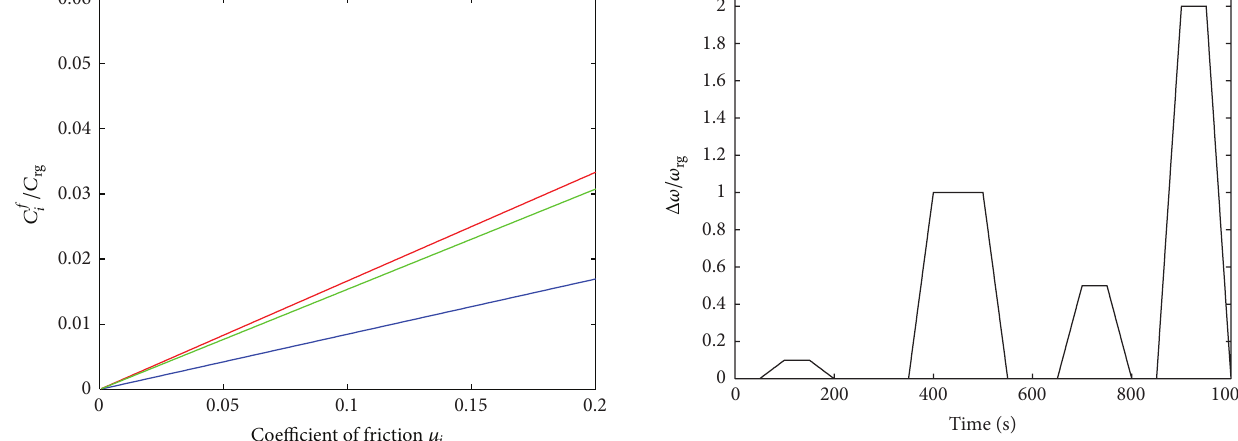
Figure 12: Example of a load parameter Δ𝜔/𝜔 with a complex path rg as a function of coefficient of = 0 (in the case rg depending on time 𝑡 ∈ [0,1000 s ] : when Δ𝜔/𝜔 rg ̸=0 and 𝜔 ̸= 0 ) then 𝜂 = 1 and 𝑙 = 𝑃 /𝑃 = 0 , ∀𝑖 (when where 𝜔 /𝐶 𝑖 𝑖 lw rw di rg increased linearly with 𝜇 < 2 ax / sa rg ax / sa thevehiclewastravellingalongastraightline),when 0 < Δ𝜔/𝜔 /𝐶 = 𝜇 rg increased linearly with 𝜇 (blue < 1 and 𝑙 = 𝑃 /𝑃 > 0 , ∀𝑖 (when the vehicle was taking a sa / sh rg sa / sh sh then 𝜂 /𝐶 = 𝜇 𝑖 𝑖 di rg increased linearly with 𝜇 (green solid = 2 then 𝜂 < 1 and 𝑙 = 𝑃 /𝑃 > pl / sh rg pl / sh sh curvilinear course), when Δ𝜔/𝜔 𝑖 𝑖 rg di rg 0 , ∀𝑖 (when one of the driven wheels underwent slipping, the vehicle = constant and |𝜔 −𝜔 | = was stationary); on the plateau, Δ𝜔/𝜔 rg lw rw constant (the vehicle was taking a constant curvilinear